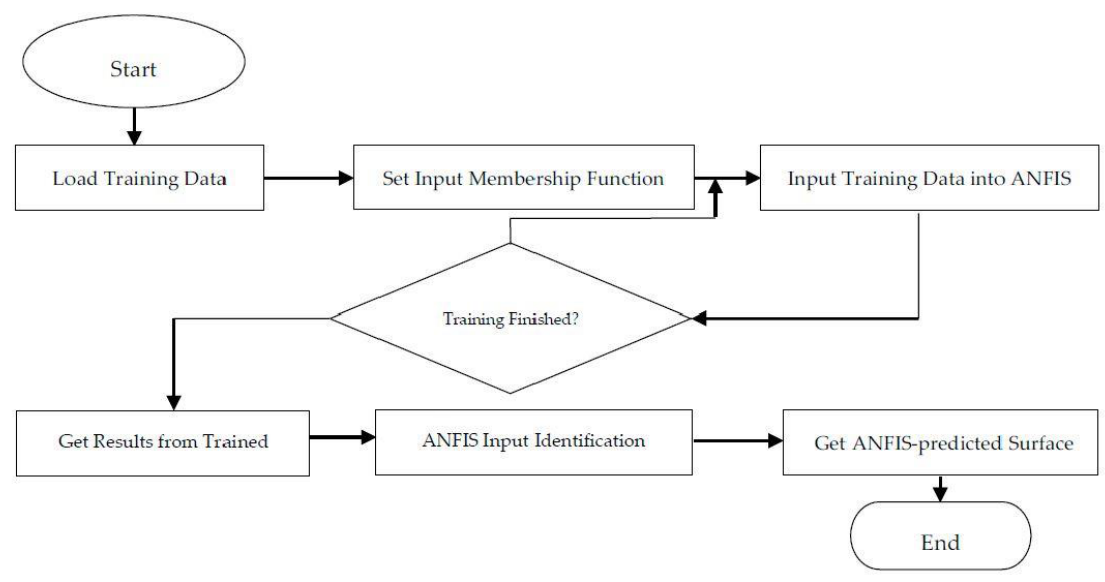
Figure 2. The ANFIS Engineering.